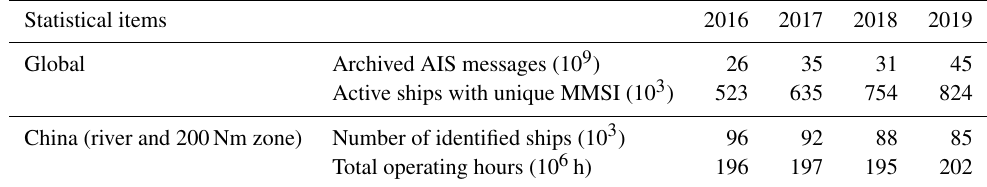
Figure 2. Definition of the study area for ship emission estimation around China. The double-nested domain is used to filter global AIS data and reduce the boundary effect. The distances on the map all refer to the distance from the baseline of the Chinese mainland’s territorial waters. The 200Nm zone is the coastal area approximately within 200Nm away from the baseline, which is further divided into different geographic regions according to the distance lines. Table 1. Statistics of AIS messages and active ships in